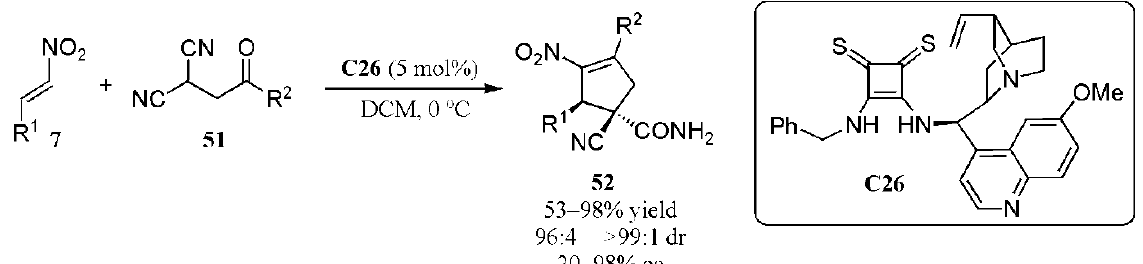
Figure 33. Enantioselective synthesis of cyclopentenes 127 [66].